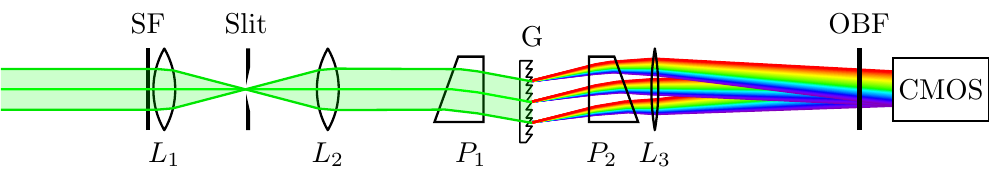
Figure 2. Optical concept of hyperspectral imagers. Sketch of the light path entering the instrument as it first gets spatially filtered by a slit and subsequently separated by a holographic grating: SF denotes the spectral flattening filter, L 1 the front optics, L 2 the collimator, P 1 the entry prism, G the volume-phase holographic transmission grating, P 2 the exit prism, L 3 the focuser, OBF the order blocking filter, CMOS the imaging